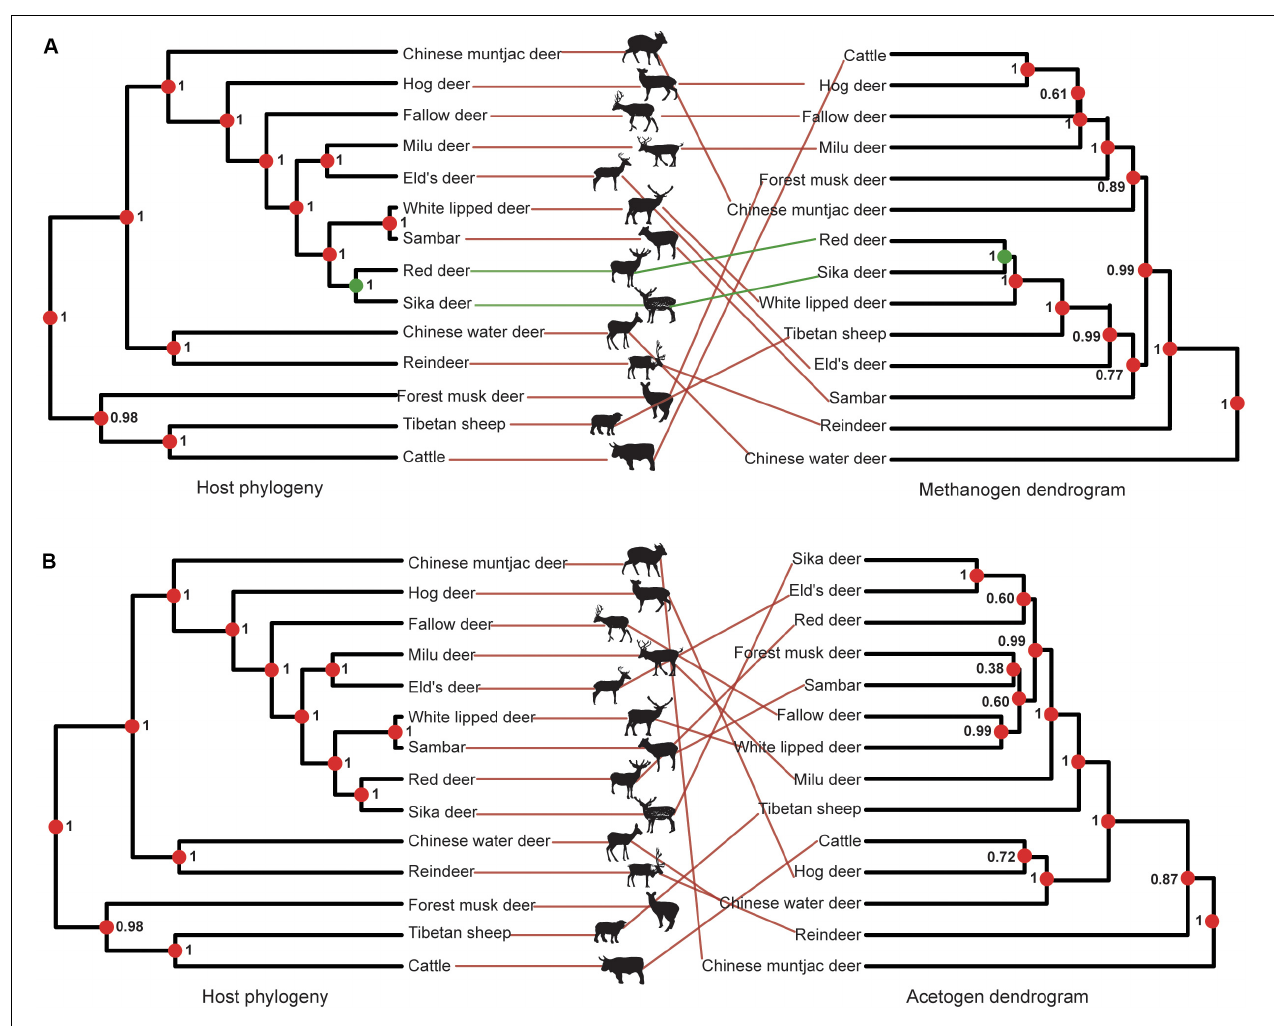
FIGURE 5 | Phylosymbiosis between host phylogeny and microbiota composition dendrograms. (A) Phylosymbiosis between host phylogeny and methanogen composition dendrograms. (B) Phylosymbiosis between host phylogeny and acetogen composition dendrograms. Node dot color indicates whether the node contains the same (green) or a different (red) combination of taxa as the paired tree. Node values indicate posterior probabilities in the host phylogeny and node support based on 1,000 iterations of UniFrac distances in microbiota composition dendrograms. The color of lines connecting the taxa indicates whether taxa are located in identical (green) or different (red) subtrees in both